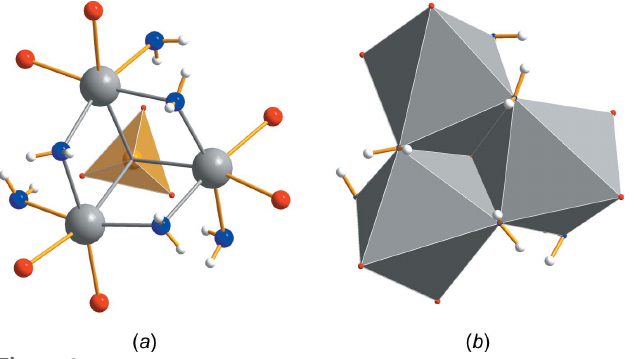
Figure 6 Representation of the sodium ion coordination within a trimeric unit: (a) stick and ball, ( b ) polyhedrons.